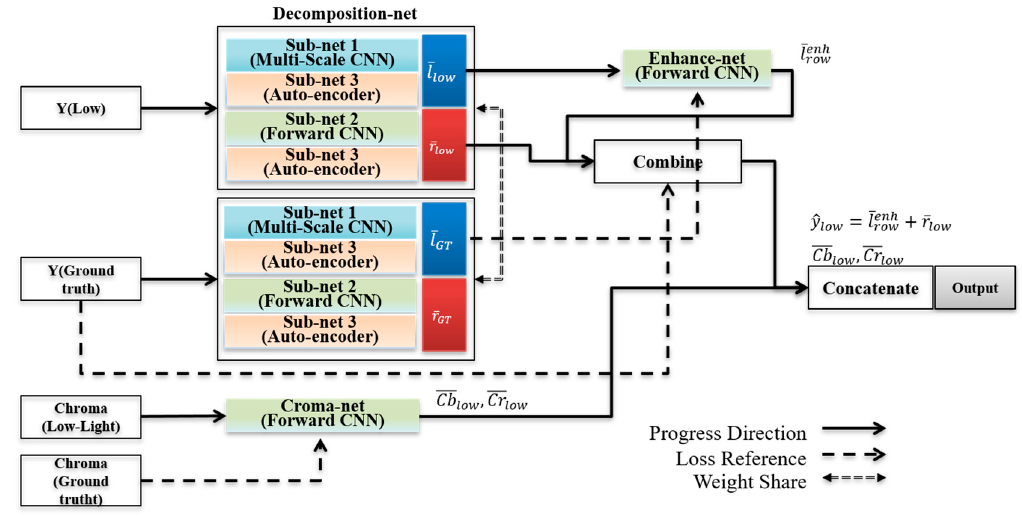
Figure 2. Flowchart of proposed